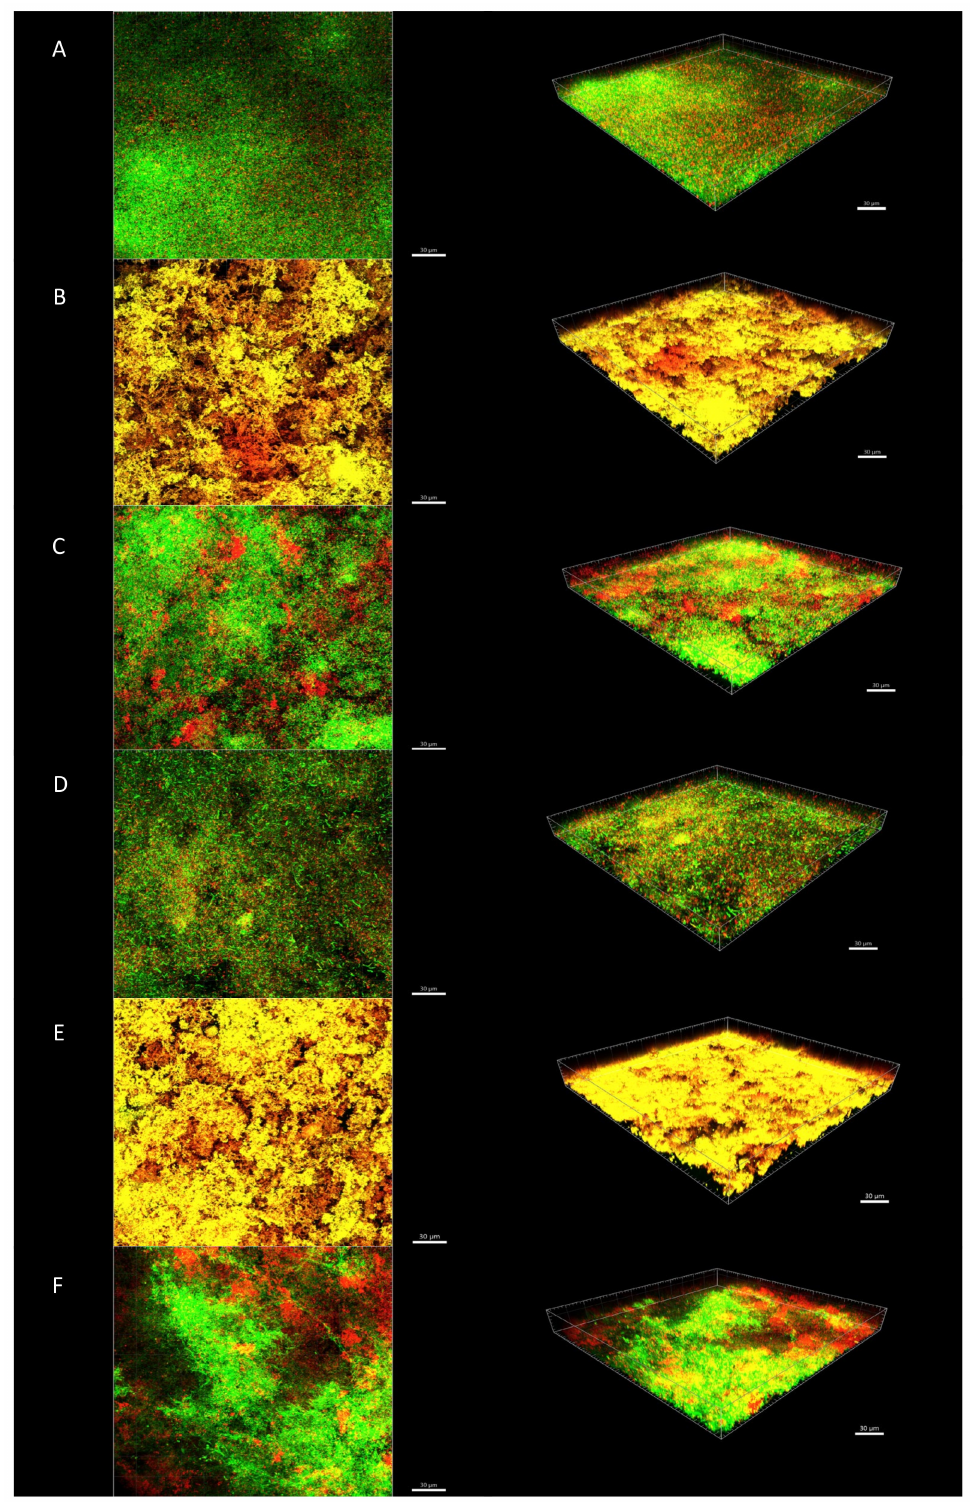
Figure 3. Confocal laser scanning microscopy images of in vitro biofilms after 24 h treatment. ( A ) Control group with no treatment; ( B ) 2% CHX; ( C ) eight D-AAs; ( D ) high-purity nisin; ( E ) high-purity nisin + 2% CHX; and ( F ) high-purity nisin + eight D-AAs. The biofilms were stained using the LIVE/DEAD Viability Kit; live cells appear green and dead cells red. Images represent the 3D reconstructions of the biofilms using the IMARIS 7.6.5 software (orthogonal and perspective views from left to right). Scale bar 30 µ